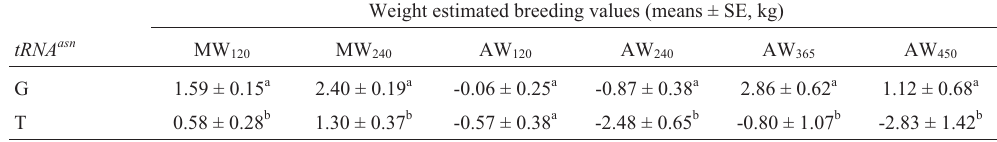
Table 3 - Weight estimated breeding values (EBV) for the G5501 → T (G, n = 247; T, n = 71) mitochondrial tRNA asn gene single nucleotide polymor- phism (SNP). The table shows the means and standard errors of the mean (SE) for maternal EBV for weight (MW) at 120 and 240 days and animal EBV for weight (AW) at 120, 240, 365 and 450 days.